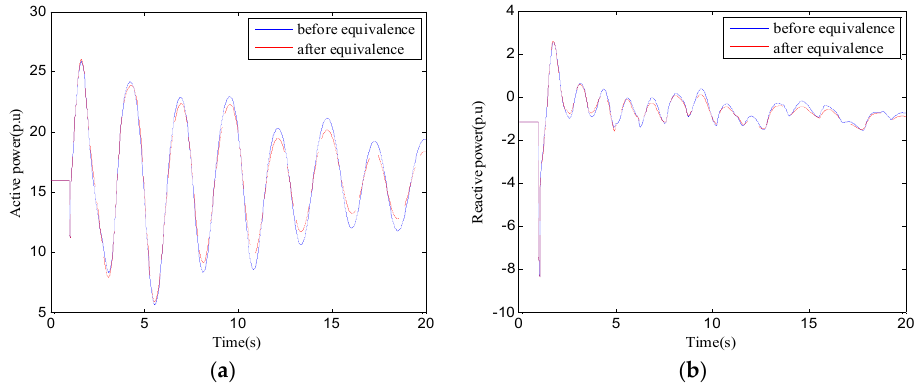
Figure 10. ( a ) Active power curves between before and after equivalence; ( b ) reactive power curves between before and after equivalence.